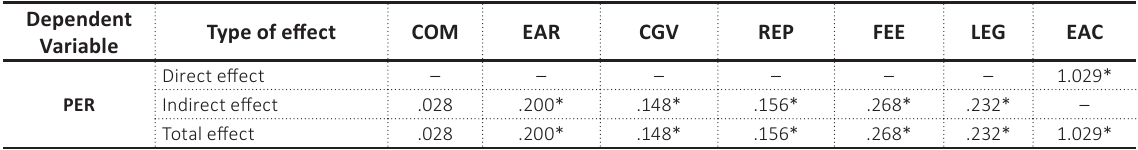
Table 6. Summary of effect